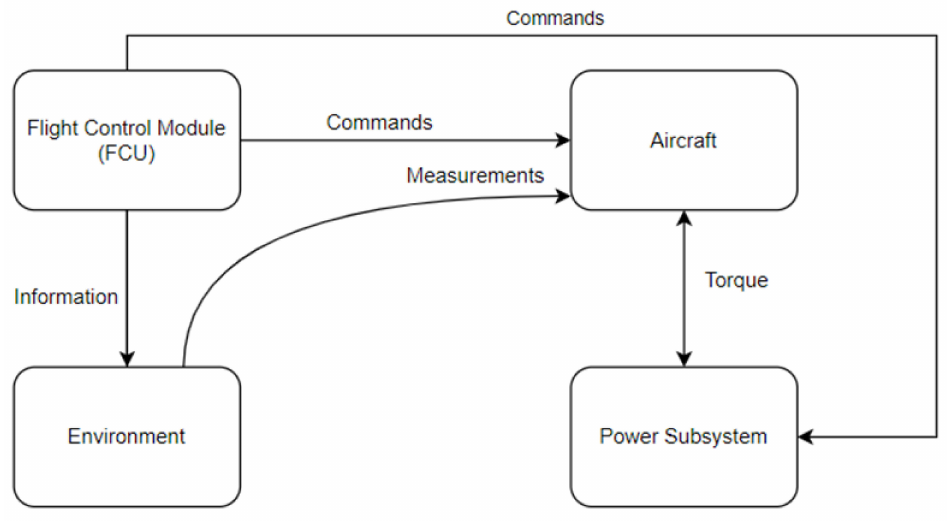
Figure 2. Model components and their